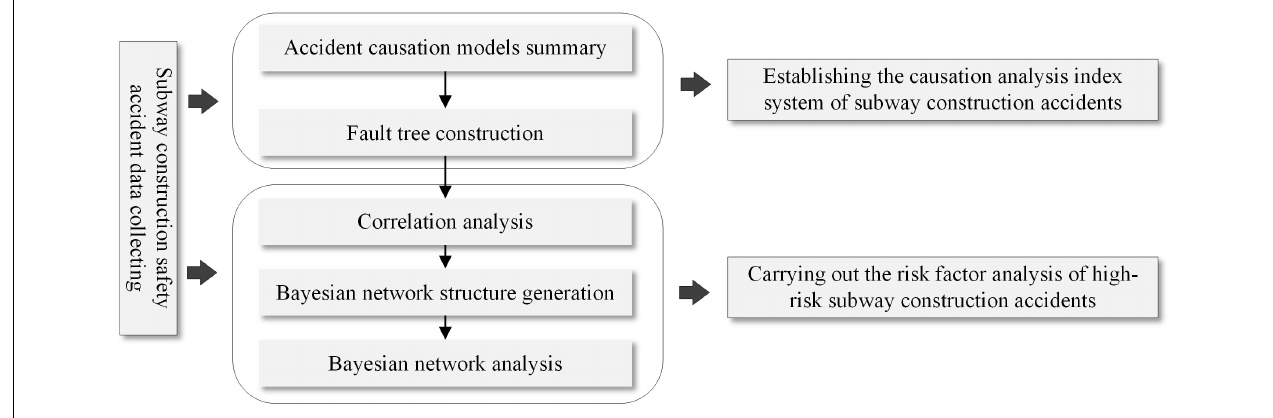
FIGURE 2 | Framework for data analysis.